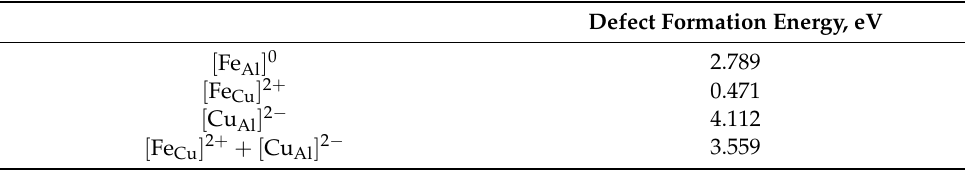
Table 2. Calculated defect formation energies in CuAlS 2